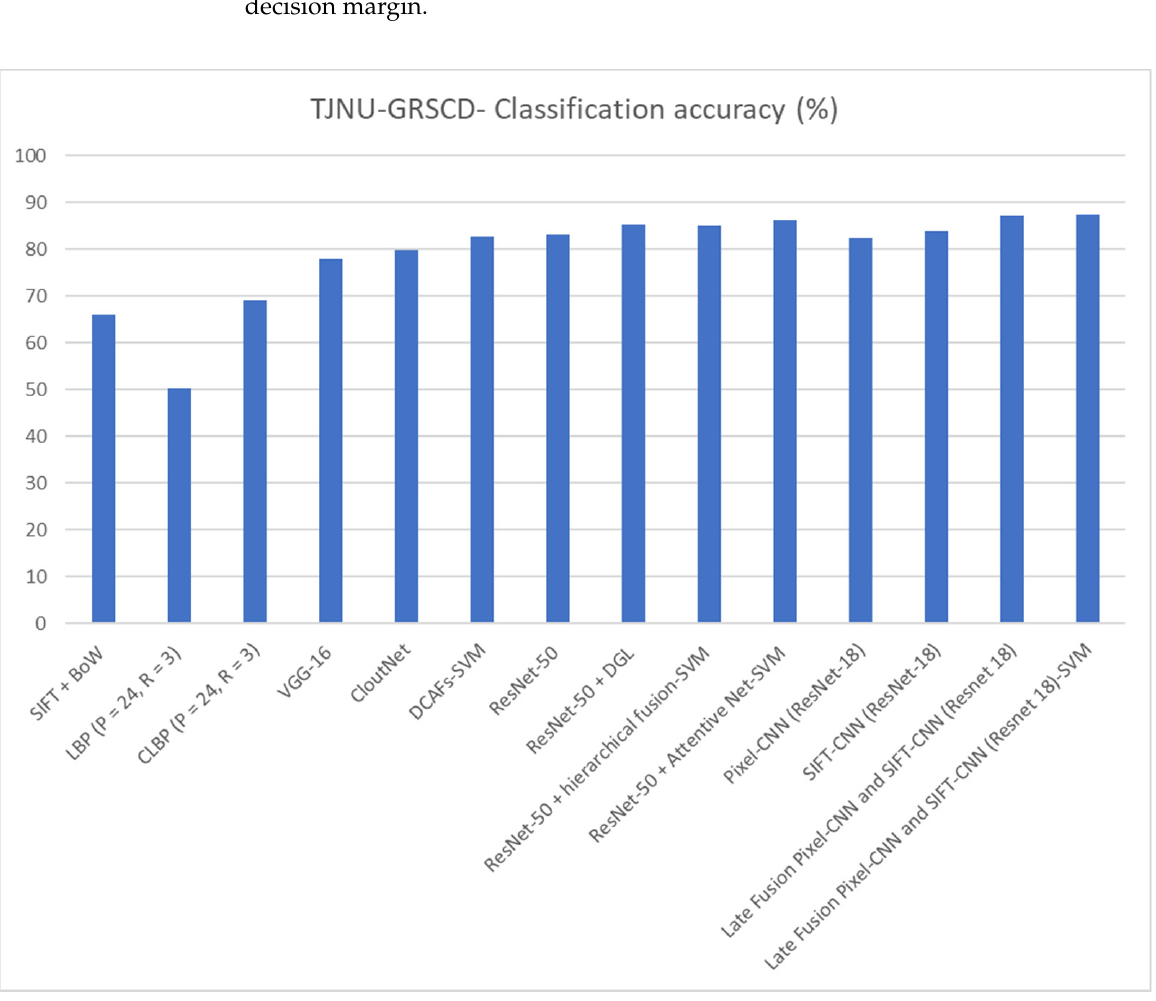
Figure 5. Bar plot showing the classification results for the ground-based image-cloud database (TJNU-GRSCD) for a variety of methods.